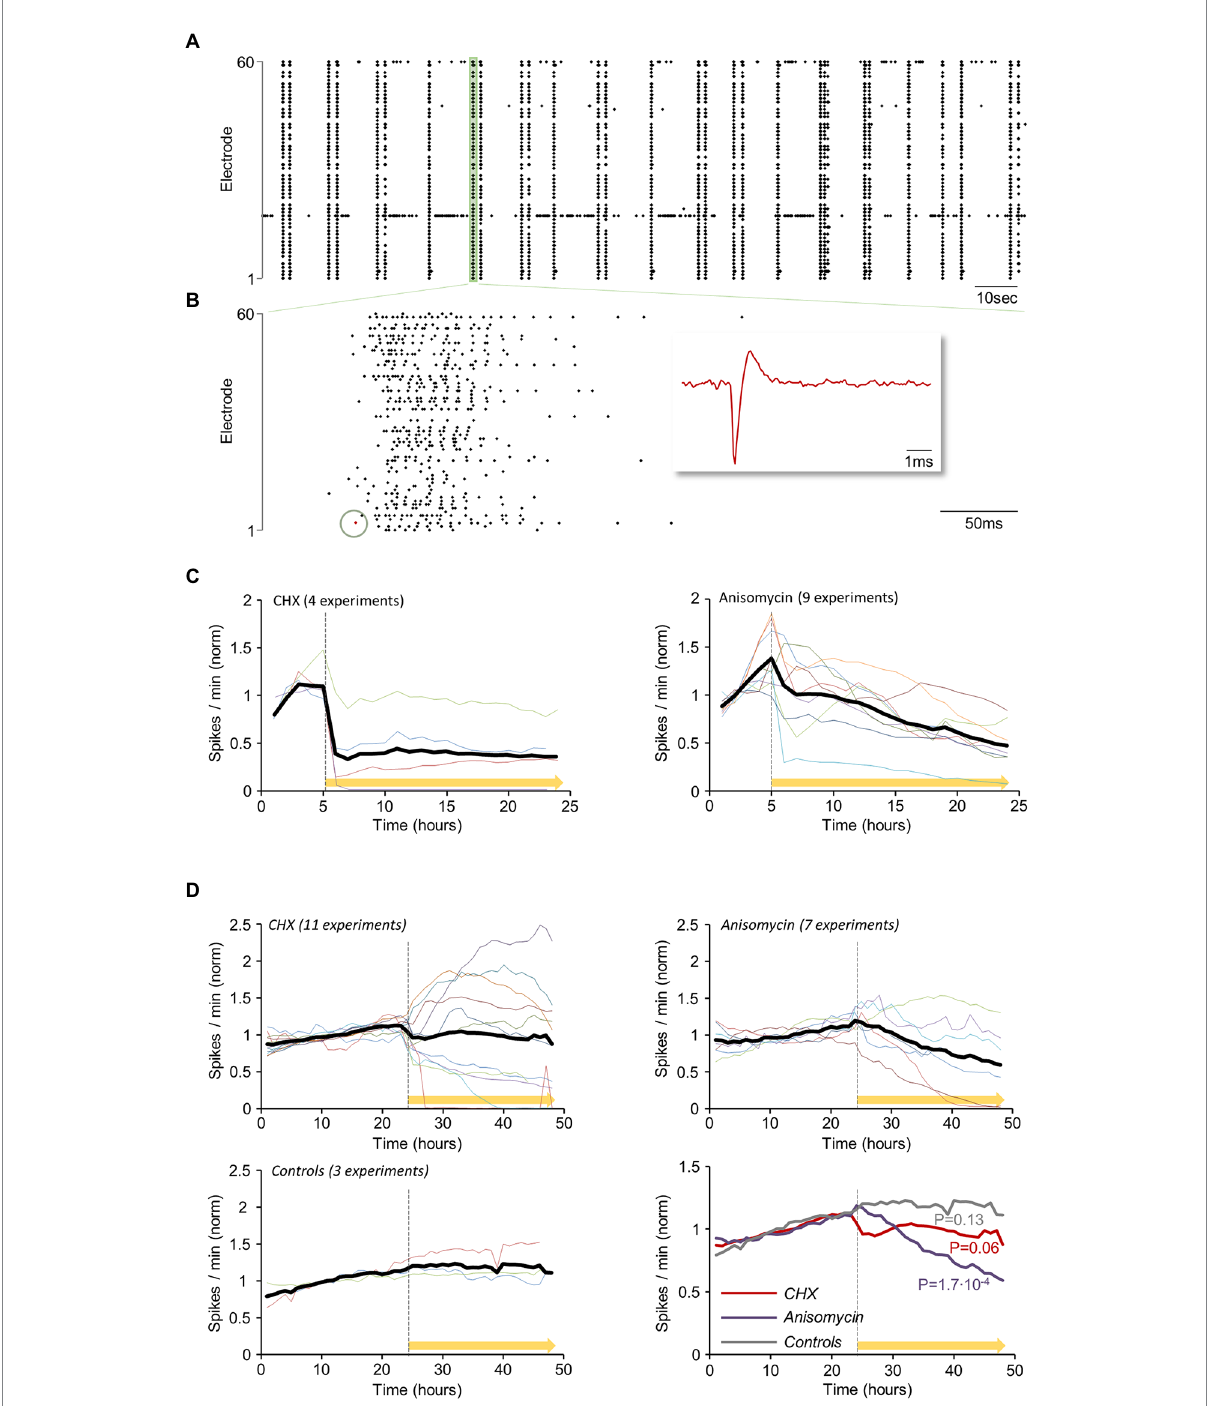
FIGURE 5 Reductions in spontaneous network activity levels within hours of protein synthesis inhibition. Rat cortical neurons were grown on multielectrode array (MEA) substrates for 2.5–3.5 weeks. The preparations were then mounted on an MEA amplifier and action potentials (APs) were recorded from the 59 MEA electrodes. (A) Spontaneous network activity measured by MEA recordings: Action potentials (APs, Spikes) recorded from all electrodes (3-min excerpt of a recording). (B) Higher magnification of the region highlighted in green at (A) . Each dot corresponds to a threshold crossing (representing an AP fired and recorded at one of the electrodes, as shown in magnified view in the red inset, matching the red dot in the recording excerpt). (C) The spontaneous activity was measured for 5 hours, after which cycloheximide (CHX: n = 4) or anisomycin (ANI: n = 9) was added to the MEA dish (yellow bar). Recordings were then continued for another 16 hours. APs measured from all electrodes were accumulated at 1 min intervals, and normalized to mean spike rates during the first 3 hours of each experiment. Colored lines represent individual experiments (different MEAs, mostly from different cell culture preparations). Thick black line is the average of all experiments. (D) Experiments as in (C) , but